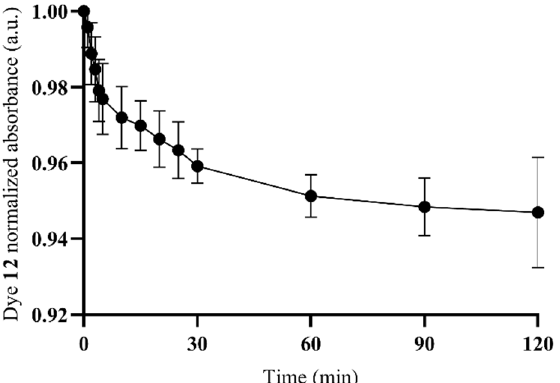
Figure 4. Photostability evaluation of the monomethine cyanine dye 12 via the analysis of absorbance decay as a function of the irradiation time. Absorbance was recorded at the maximum absorption wavelength of the dye 12 (376 nm), normalised, and presented as arbitrary units (a.u.). The results are expressed as the mean ± standard deviation of two independent assays performed in quadruplicate.